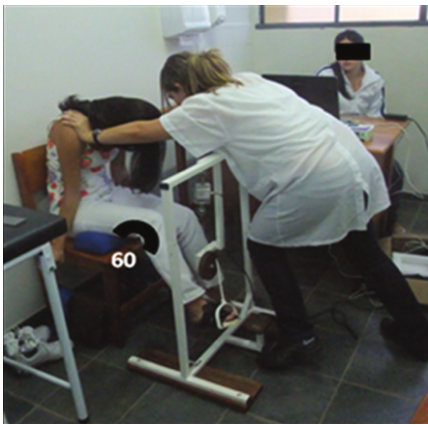
Figure 4: Trunk flexion motion.